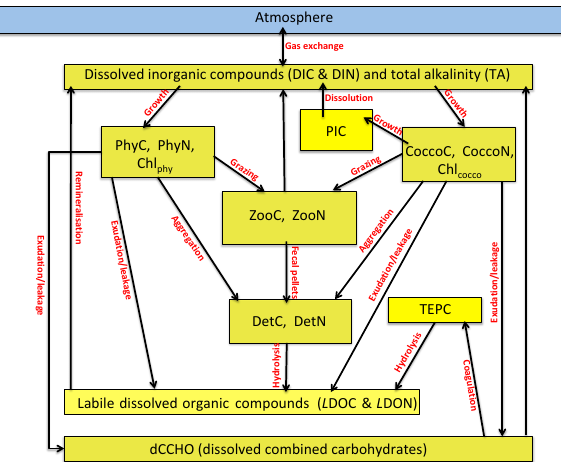
Figure 2. Schematic representation of the model: boxes characterise individual compartments that are represented by one or more model state variables. The arrows represent key biogeochemical processes (named in red) between compartments. One compartment includes dissolved inorganic carbon and nitrogen (DIC and DIN). This com- partment also embeds total alkalinity (TA). Biomass and chloro- phyll concentrations of photoautotrophs are resolved with respect to carbon and nitrogen explicitly (referred to as PhyC and CoccoC, PhyN and CoccoN, and Chl phy and Chl cocco respectively). Varia- tions in carbon and nitrogen biomass are also resolved for zooplank- ton (ZooC and ZooN) and for detritus (DetC and DetN). Dissolved combined carbohydrates (dCCHO) are distinguished from other la- bile dissolved organic matter, described as L DOC and L DON. Only dCCHO are assumed to act as precursor for the formation of trans- parent exopolymer particles, whose carbon content is explicitly re- solved (TEPC). One compartment represents the formation and dis- solution of particulate inorganic carbon (PIC), affecting DIC as well as